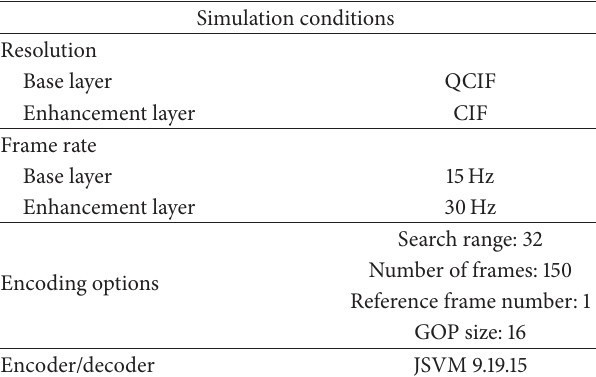
Table 3: Simulation